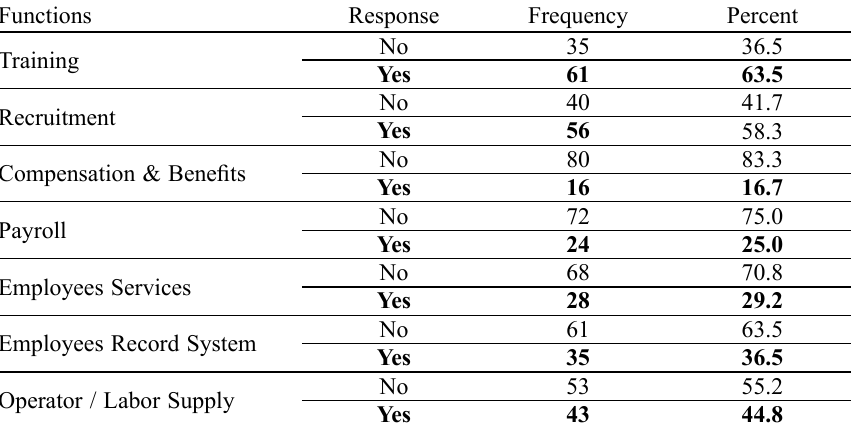
Table 2. Profile of the HR functions outsource by respondents